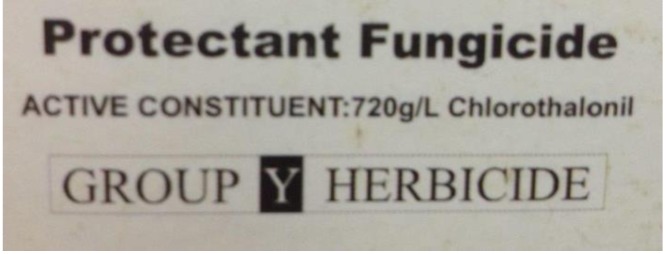
Example of pesticide labelling anomaly.Photograph from pesticide label on product for sale in Goroka.